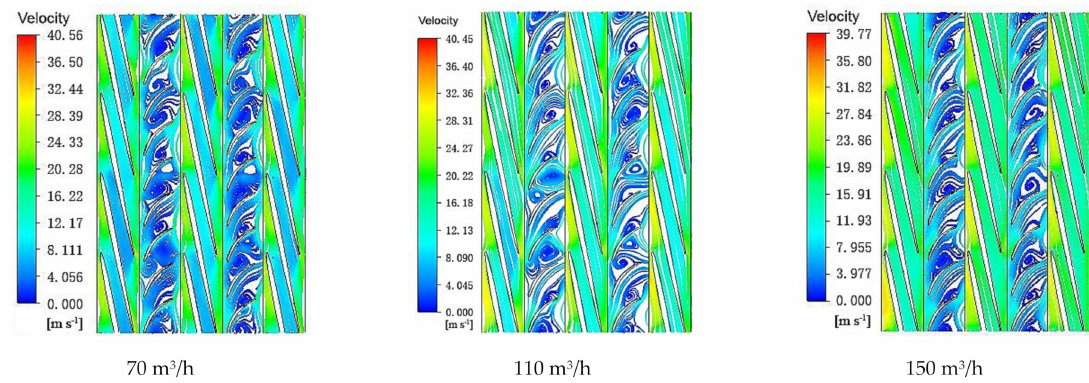
Figure 22. Axial streamline distribution at 0.5 span of the compressor